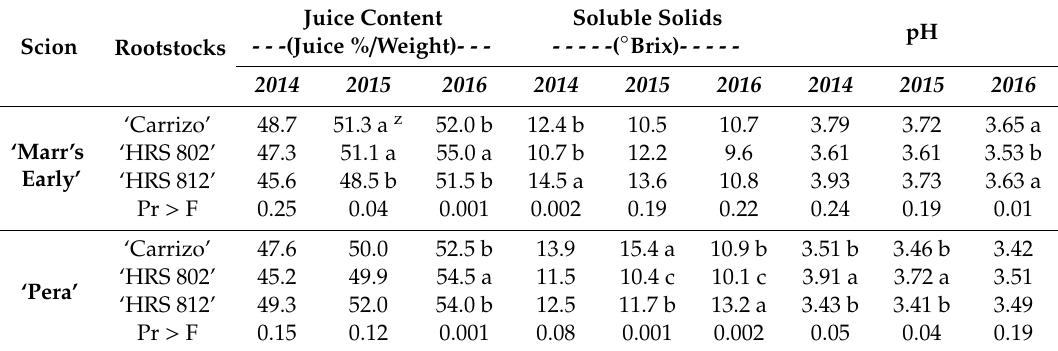
Table 5. Juice content, soluble solids, and pH of the fruit of two sweet orange cultivars grafted on three di ff erent rootstocks growing on Alonso clay series soil at the Agricultural Experiment Substation of Adjuntas, Puerto Rico in